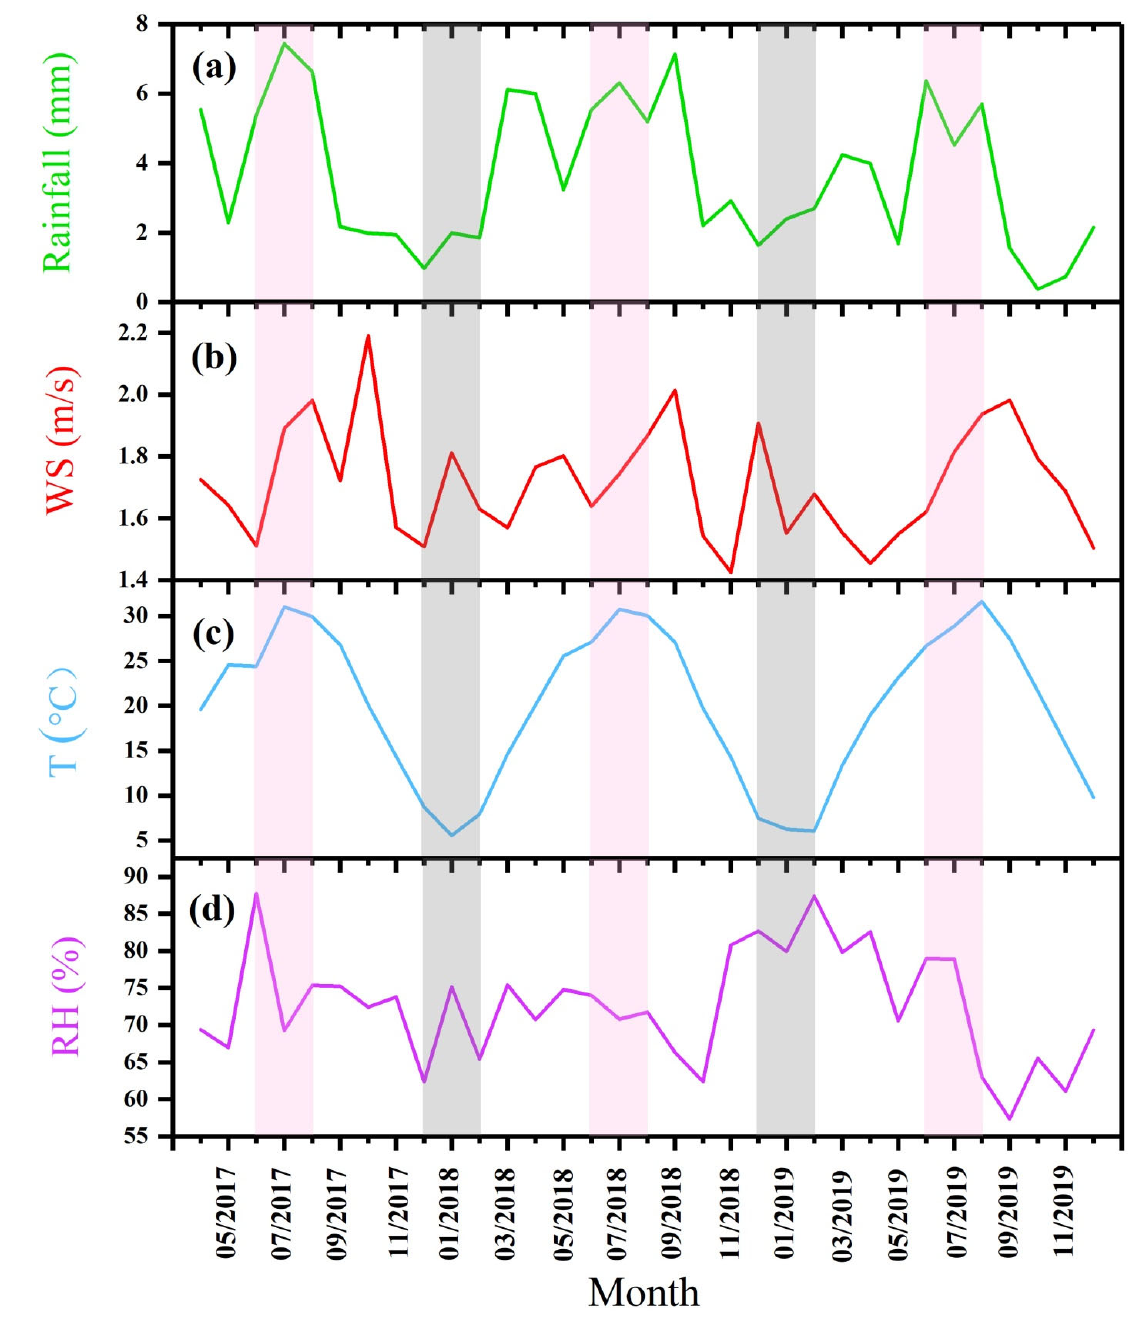
Figure 2. Time series of meteorological parameters: ( a ) Rainfall; ( b ) wind speed (WS); ( c ) temperature (T); ( d ) relative humidity (RH). The summer and winter periods are marked as shaded pink areas, and gray areas, respectively.